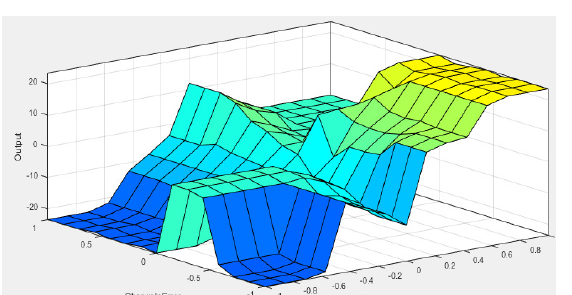
Fig 18. Fuzzy rule base for grid current control